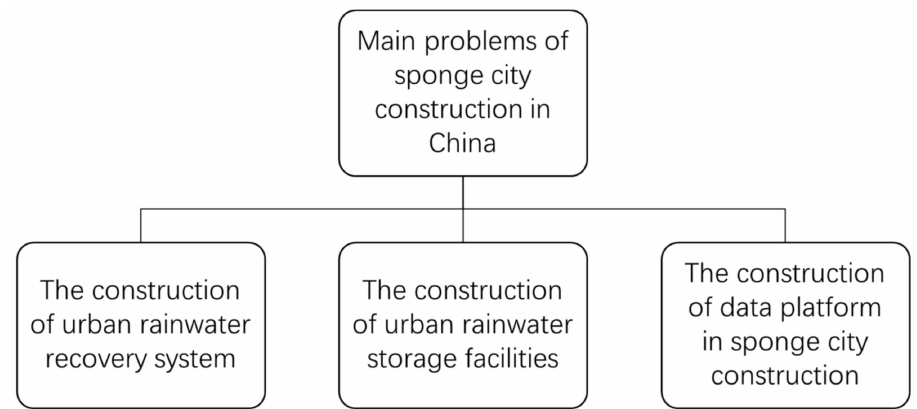
Figure 3. Main problems surrounding a sponge city construction in